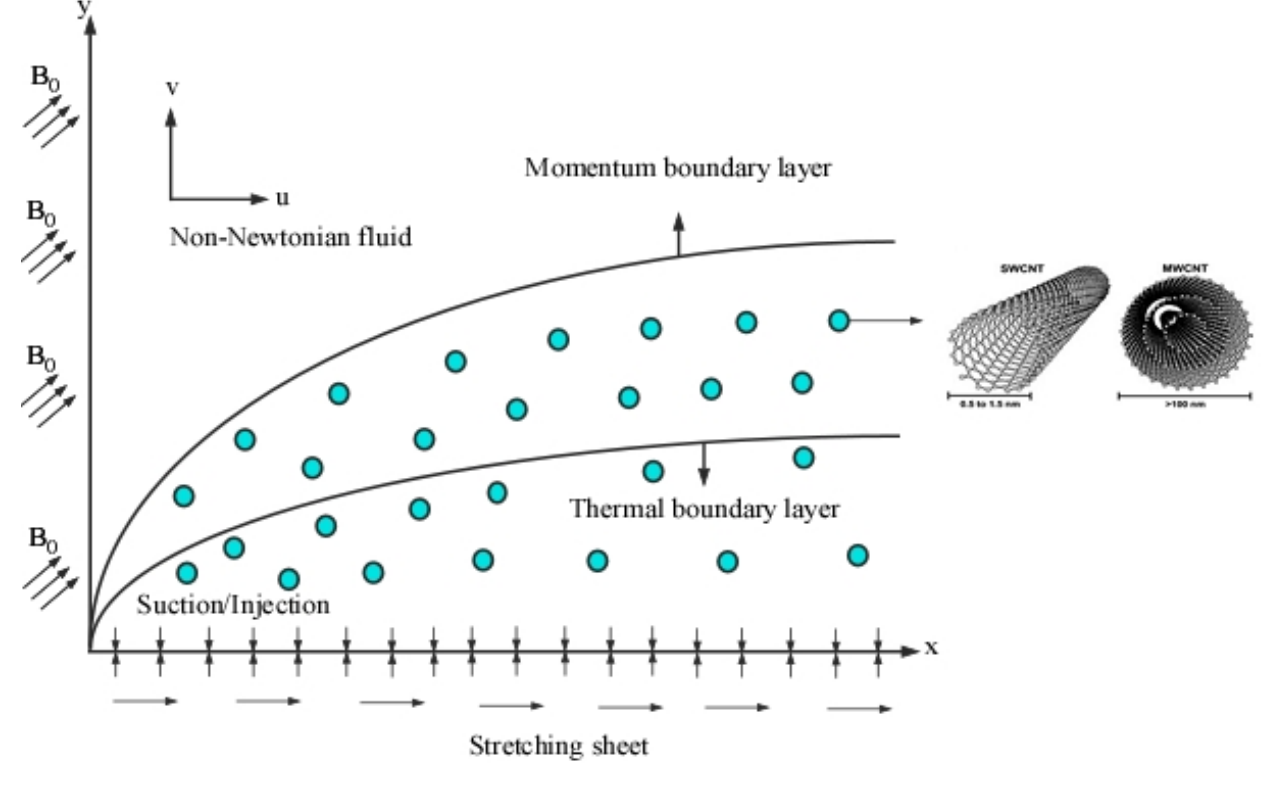
Figure 1. Physical model of coordinate system.